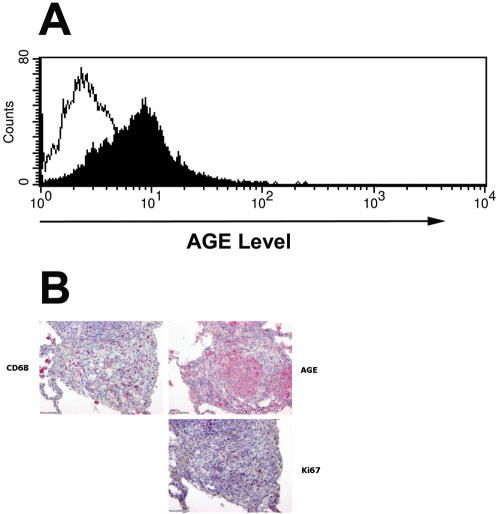
Mycobacterial Infection of Macrophages Stimulates AGE Formation. (A) Macrophages were infected with BCG for 1 day and AGE levels were determined by FACS analysis.AGE formation was strongly increased during infection of macrophages.(B) Significant formation of AGE was also observed at sites of active TB; upper left: staining with mAb against macrophage marker (CD68), upper right: staining with mAb against AGE, lower right: staining with mAb against marker for activated macrophages (Ki-67).Consistent results were observed for three TB patients.